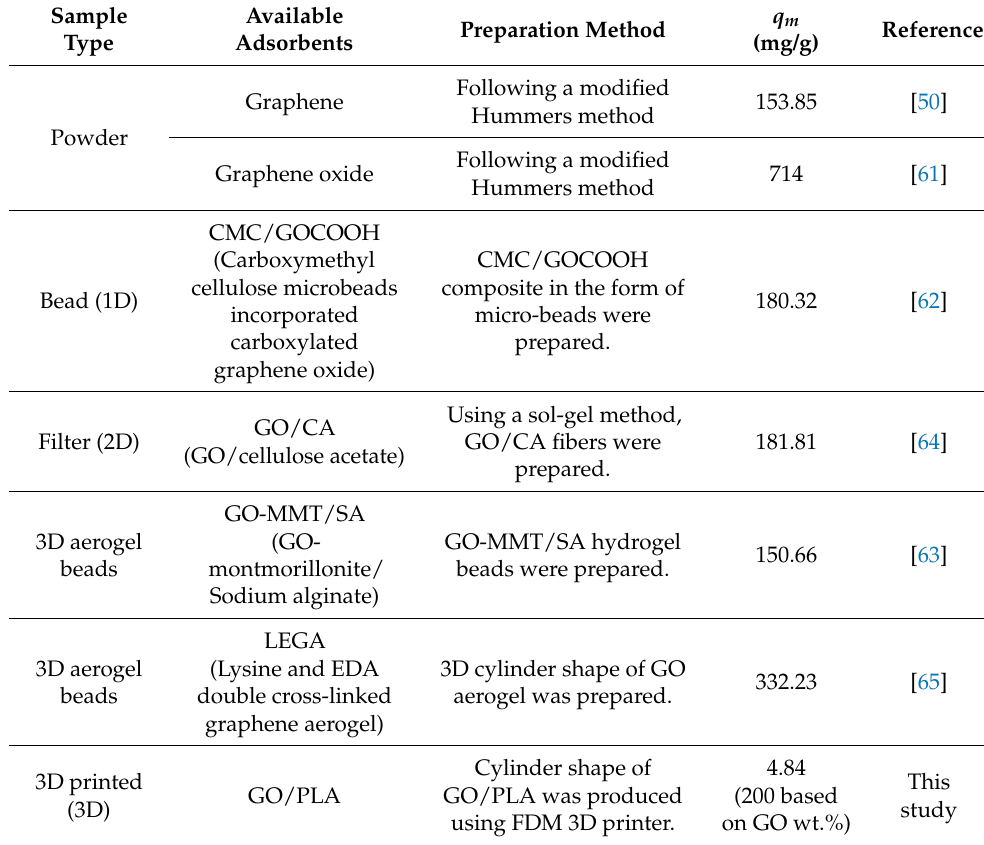
Table 4. Summary of adsorbents for MB removal from